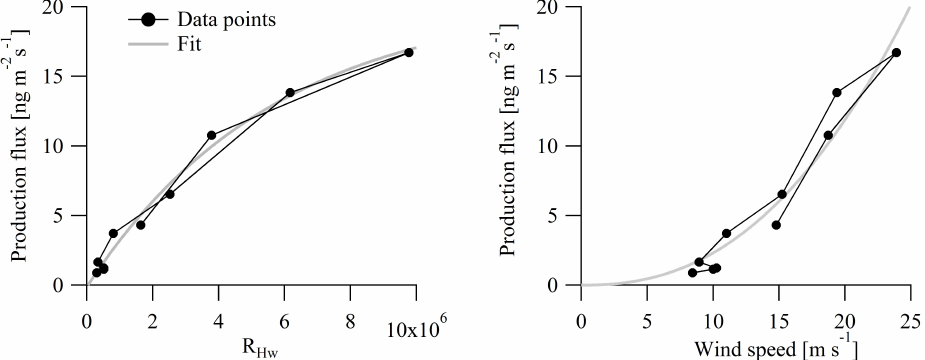
Fig. 1. Production Flux dependence on the Reynolds number, R H , (left panel) and wind speed (right panel). For the data points presented w here, the wind speed was initially increasing then levelling off and eventually decreasing, therefore, intercrossing lines for the relationship on the left panel – Flux vs. Reynolds number – indicate that there is no separation between the two regimes (increasing and decreasing wind speed), however, Flux vs. Wind speed (right panel) indicates distinctly different relationships for the different regimes, especially at higher